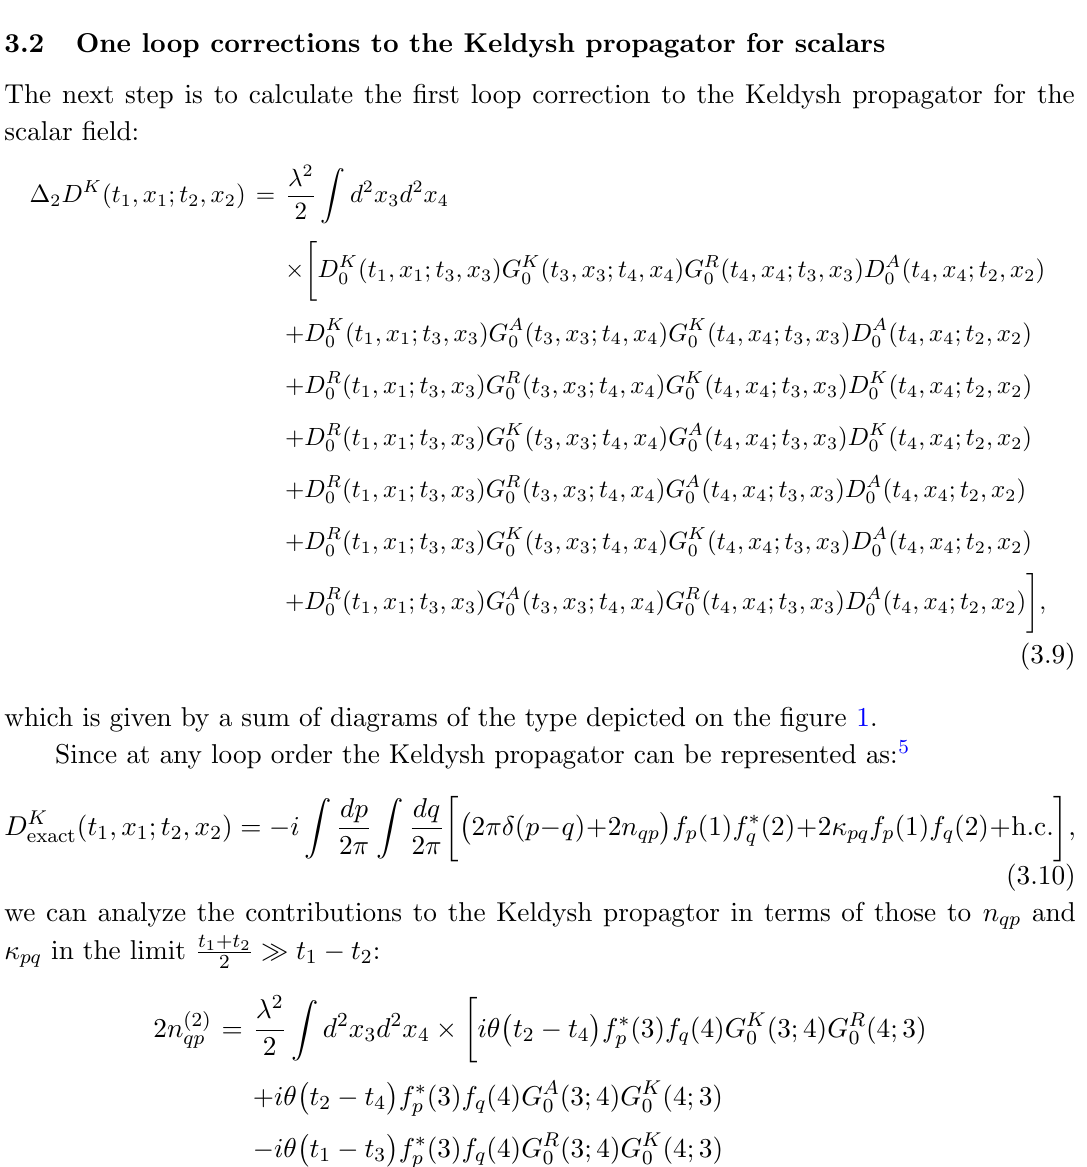
Figure 1 . One loop correction to the boson Keldysh propagator. Solid lines correspond to the tree-level fermion propagators, dashed lines correspond to the tree-level boson